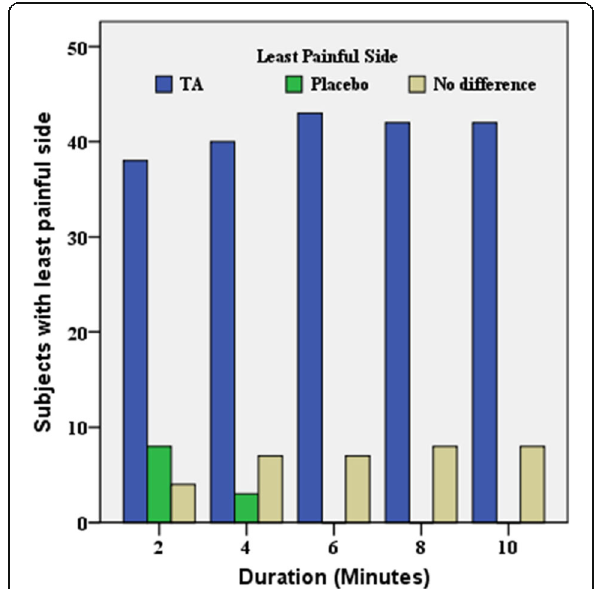
Fig. 5 Verbal scale. A graphic representation showing the least painful side as reported by the subjects favoring either the topical anesthetic (TA Oraqix®) side or the placebo (Vaseline®) side or reporting no difference between both sides